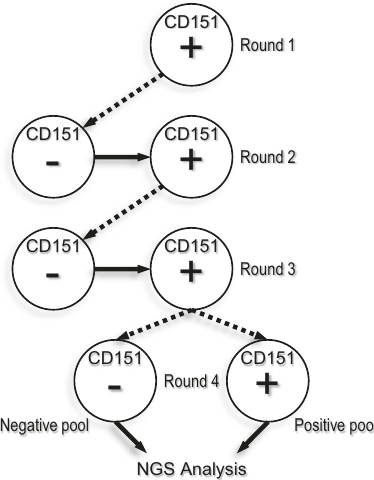
Fig. 2 CD151 in situ Ab selection process. Circles represent live HEK293T cell lines of either overexpressing CD151 (HEK293T-CD151 + ; denoted by “ + ” sign), or CD151 knockdown cells (HEK293T-CD151 − ; denoted by a “ − ” sign). For round 1, the Fab-phage (naïve library F) were incubated with HEK293T-CD151 + cells, then eluted and ampli fi ed for the next round. For rounds 2 and 3, the Fab-phage were fi rst incubated with HEK293T-CD151 − cells, then transferred and incubated with HEK293T-CD151 + cells. For round 4, ampli fi ed round 3 Fab-phage were independently incubated with HEK293T-CD151 − or HEK293T-CD151 + cells. The dashed lines with arrows indicate that eluted phage from the preceding round were ampli fi ed through E. coli prior to incubation with cells in the succeeding round. The solid lines with arrows indicate that unbound phage from the preceding cell line were transferred directly to the succeeding cell line. In round 4, phages from Fab-phage pools HEK293T-CD151 + (Positive pool) and HEK293T- CD151 − (Negative pool) were ampli fi ed and used as DNA template for NGS